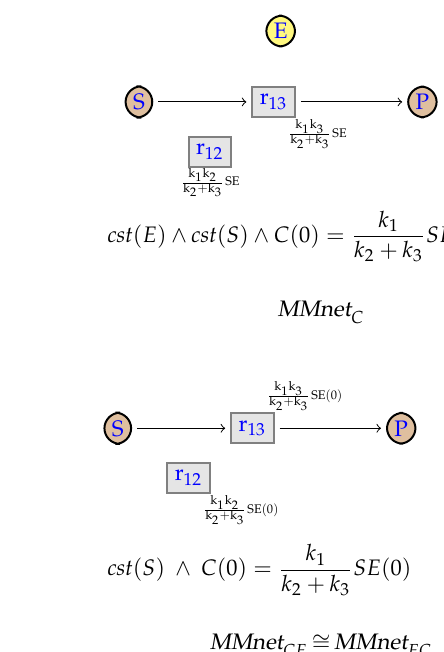
Figure 17. Reaction networks for the Michaelis-Menten example. MMnet from the initial network MMnet after removing E and C respectively. MMnet removing both C and then E in this order. MMnet